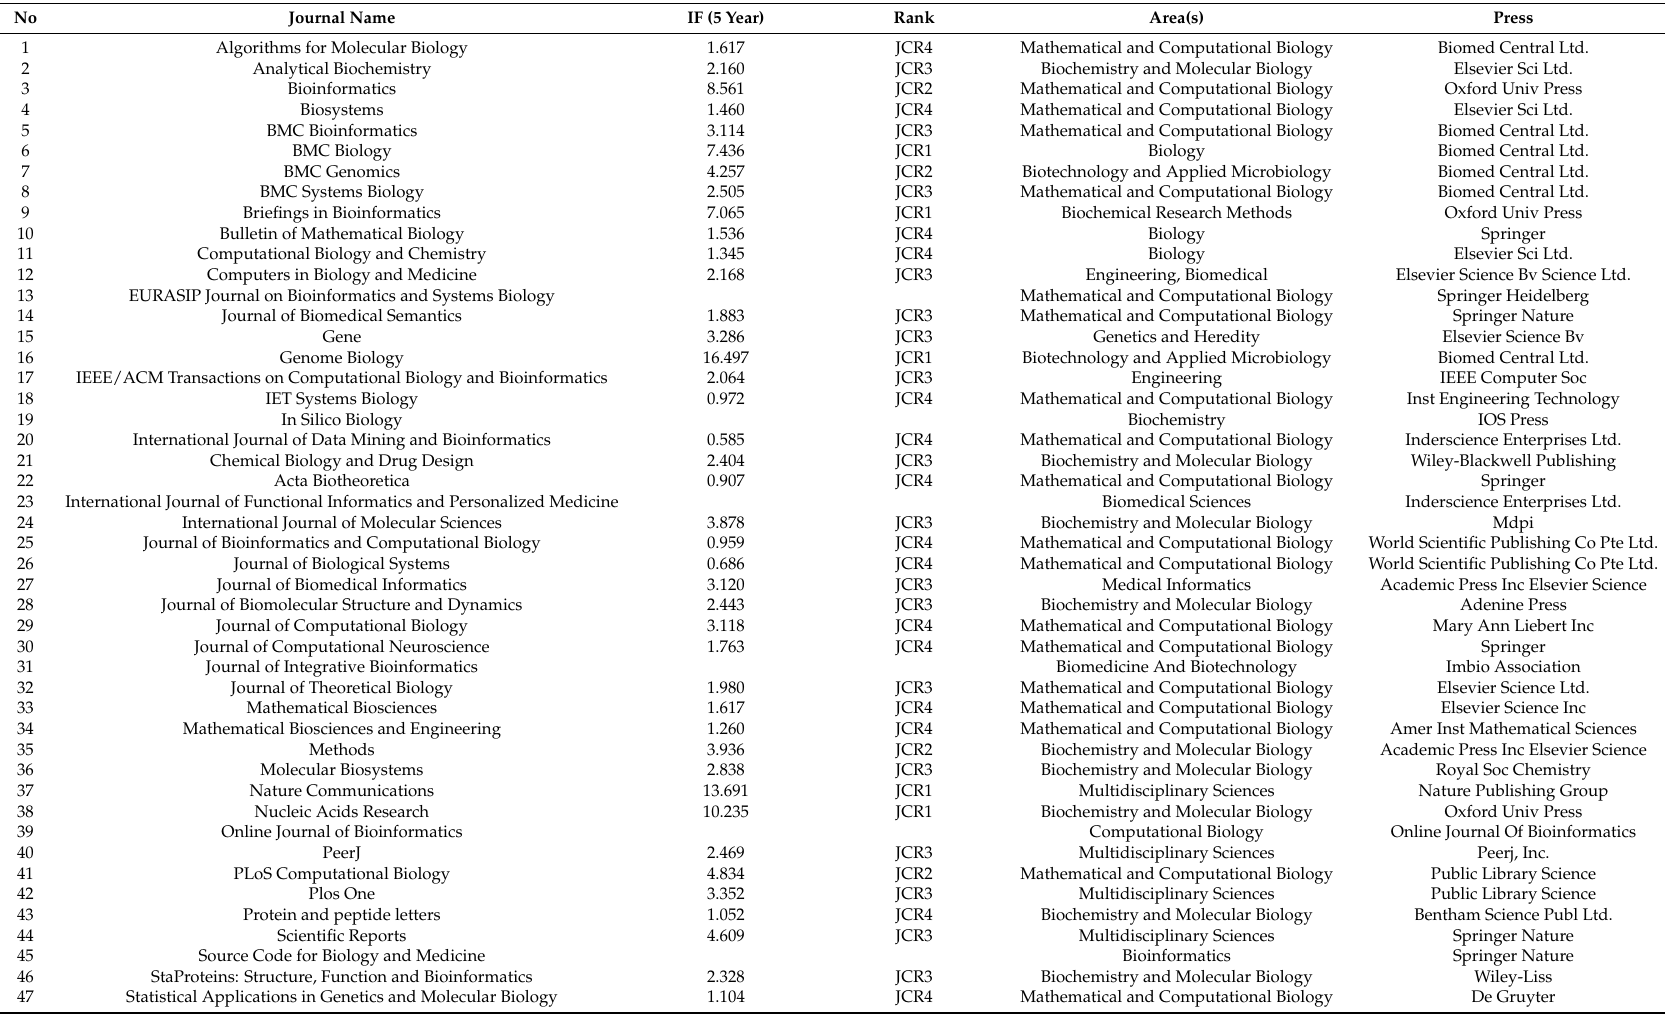
Table 1. Periodical